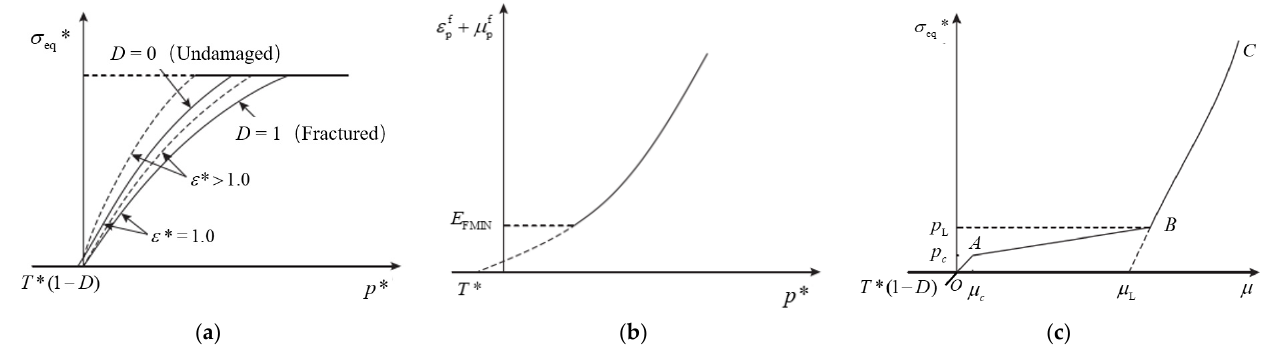
Figure 5. HJC model: ( a ) Strength model; ( b ) Damage of HJC model; ( c ) Equation of state. (2) Damage of the HJC model is accumulated from both the equivalent plastic strain and plastic volumetric strain, as in Equation (6) and Figure 5b: